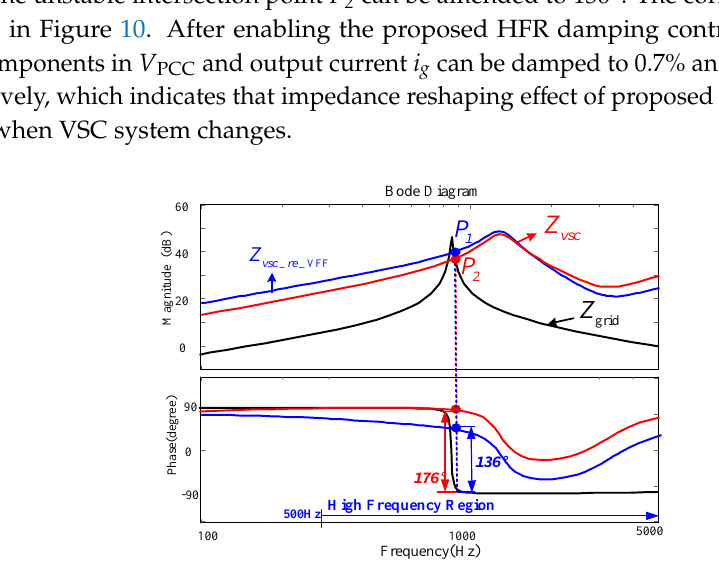
Figure 9. Impedance reshaping effect for 1 kW VSC system with different parameters.